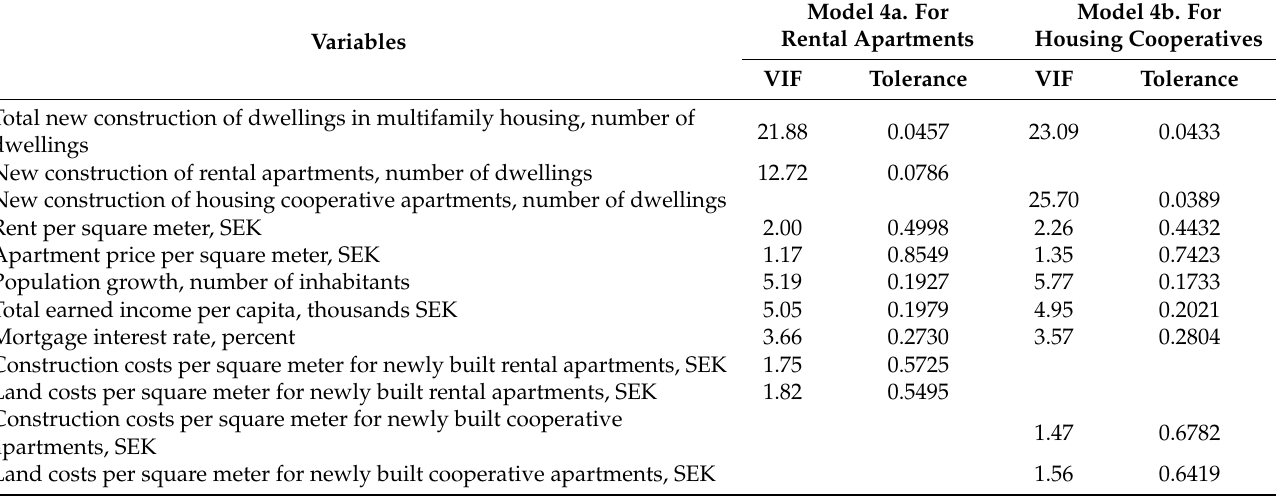
Table A7. Results of the VIF tests on variables in models 4a and 4b.